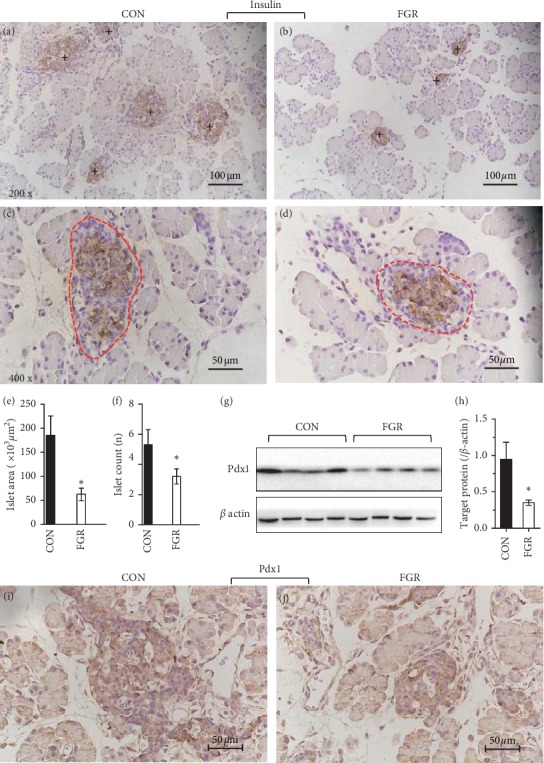
Fetal pancreatic histopathology. (a–f) Analysis of the islet index by insulin staining. Representative photomicrographs of IHC staining for insulin at 200x (a, b) or 400x (c, d) magnification in the pancreas of control (a, c) and FGR (b, d) fetuses. (e–f) Analysis of the islet index. Islet area (e) were calculated based on the photomicrographs at a magnification of 400x. (f) Islet count was calculated based on the photomicrographs (black cross marks the islet) at 200x. (g, h) Representative photomicrographs of immunoblotting results for Pdx1, an \ cell marker. Data are expressed as means ± SEM. ∗p < 0.05 vs. controls (n = 5-6). (i, j) Representative photomicrographs of IHC staining for Pdx1 at 400x magnification in the pancreas of control (i) and FGR (j) fetuses.